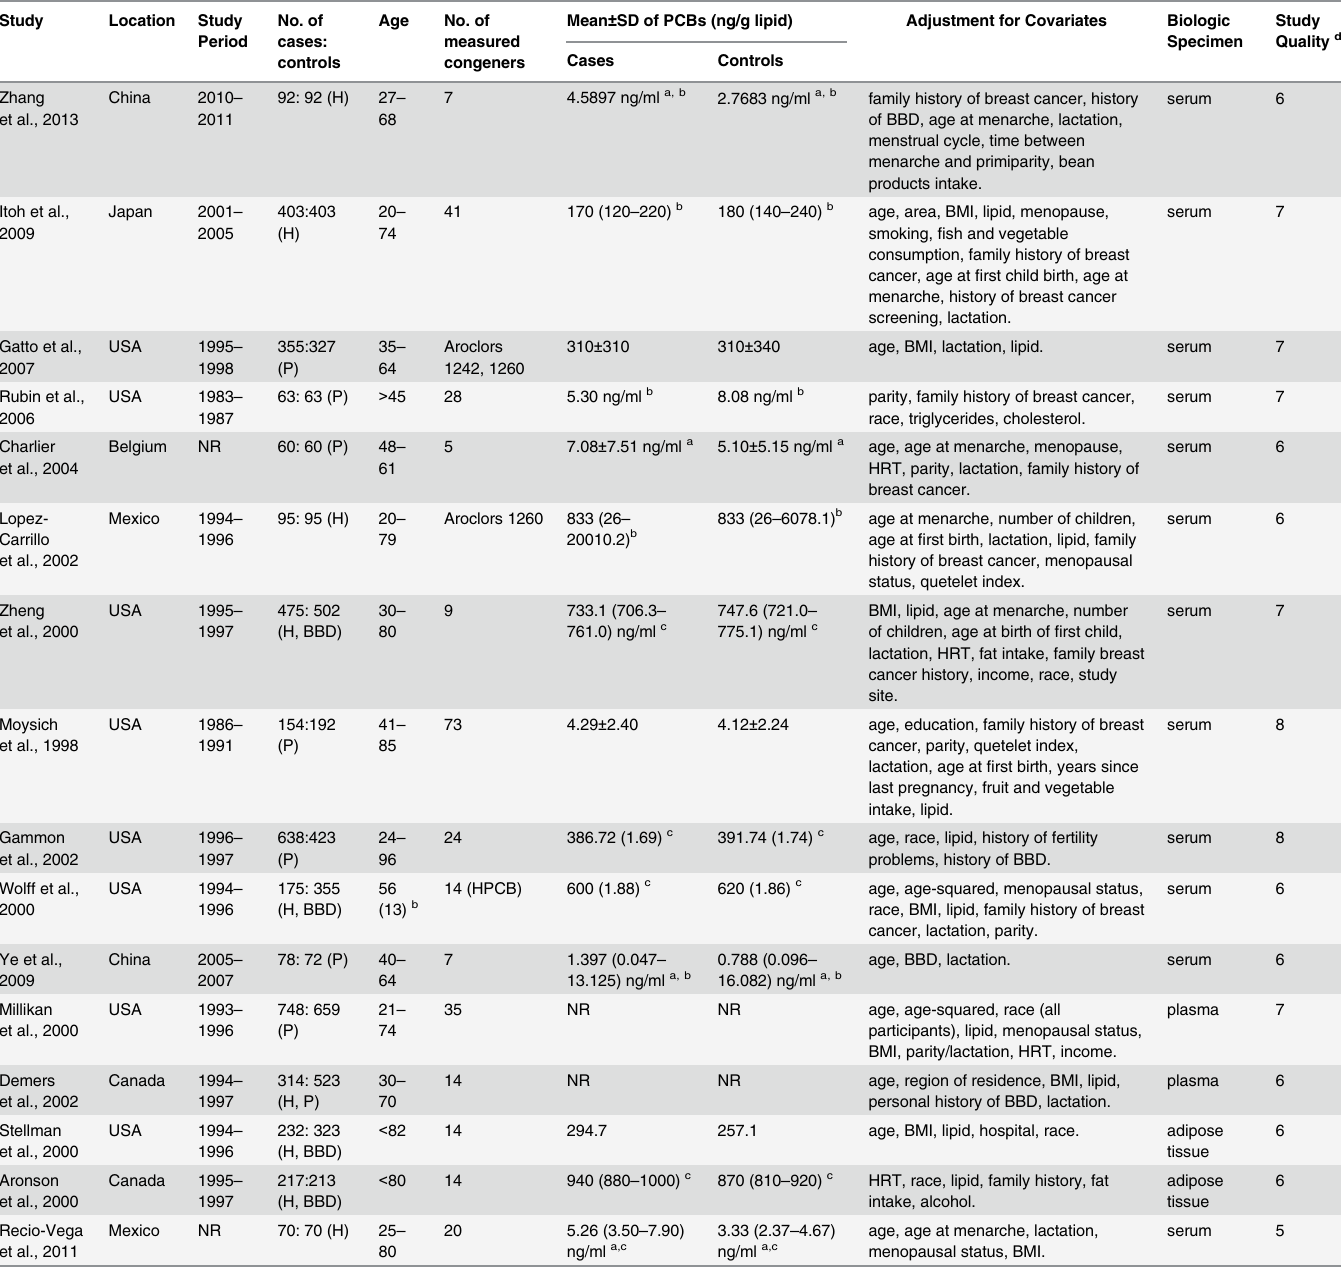
Table 2. Characteristics of retrospective epidemiologic (case-control) studies on PCB exposure and breast cancer